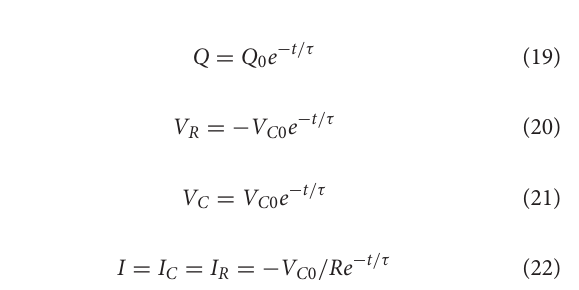
FIGURE 4 | The charging process of the MC neuron circuit, (A) the membrane capacitor charging process, (B) the charging current of the MC neuron circuit, (C) the changing of charges on positive and negative plates of the membrane capacitor, (D) the power variation of the MC neuron